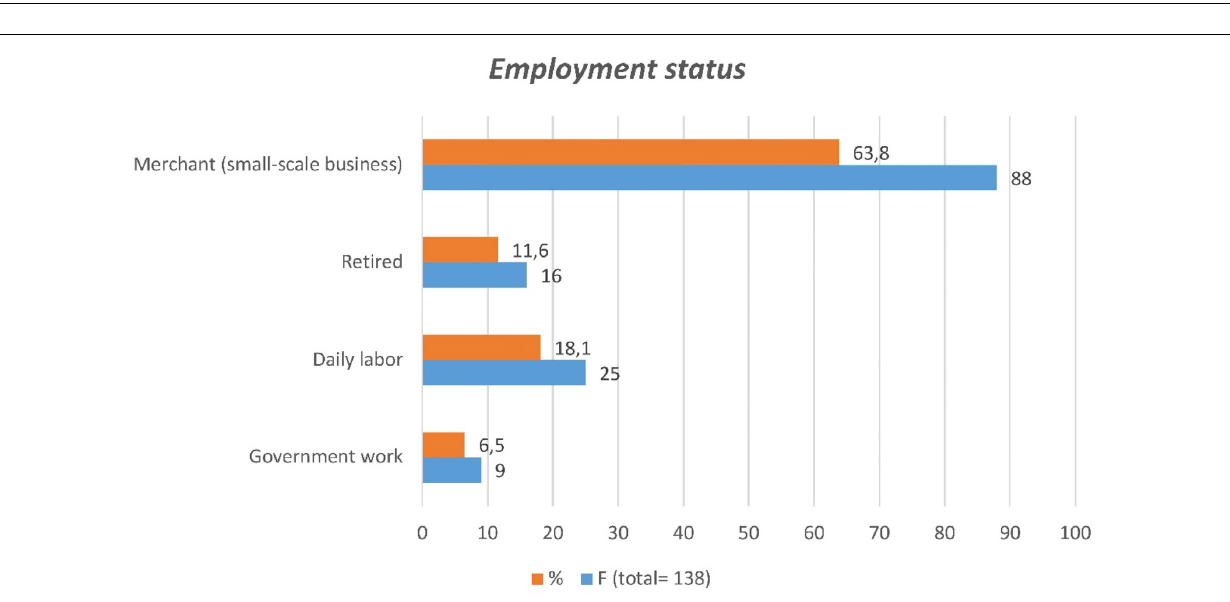
FIGURE 2 | Employment status of parents and